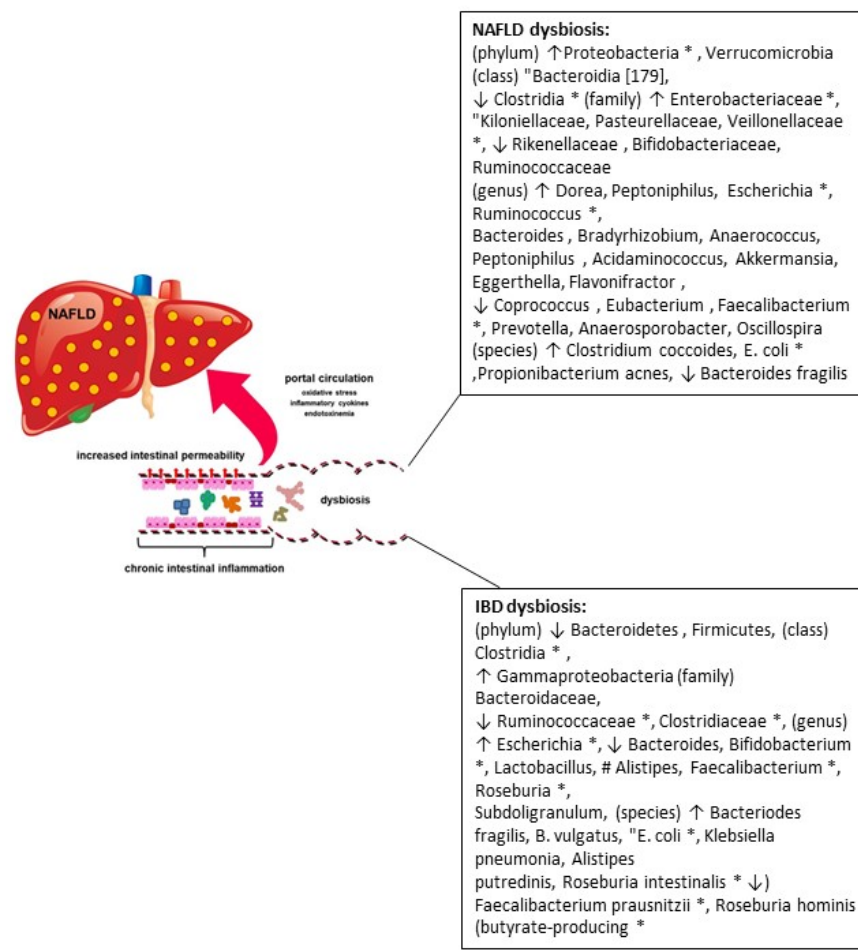
Figure 1. Increase in intestinal permeability, oxidative stress (e.g., starting of inflammatory response with intestinal mucosa damage), endotoxemia (namely, lipopolysaccharide concentration) and gut dysbiosis in IBD patients, involved in the onset and development of NAFLD. ↑ increased abundance; ↓ decreased abundance; * shared gut dysbiosis between NAFLD and IBD patients.